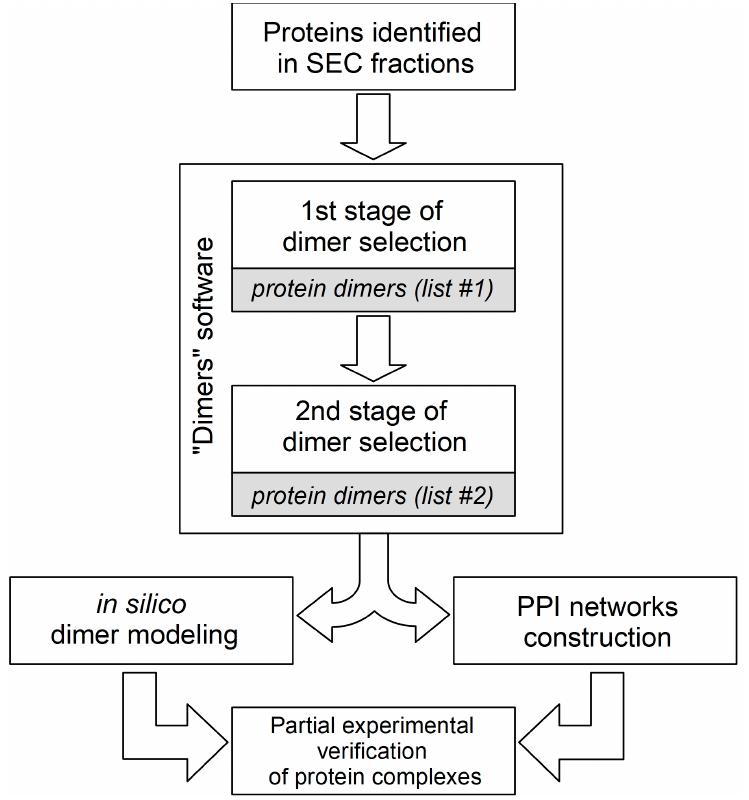
Figure 3. Algorithm for interpreting data on protein–protein dimers in fractions obtained by SEC separation. It consists of two stages of generating dimer hypotheses in the “Dimers” program; as a result, two lists of hypotheses are formed. There is also a selection of the most prioritized hypotheses by in silico methods for further experimental verification.